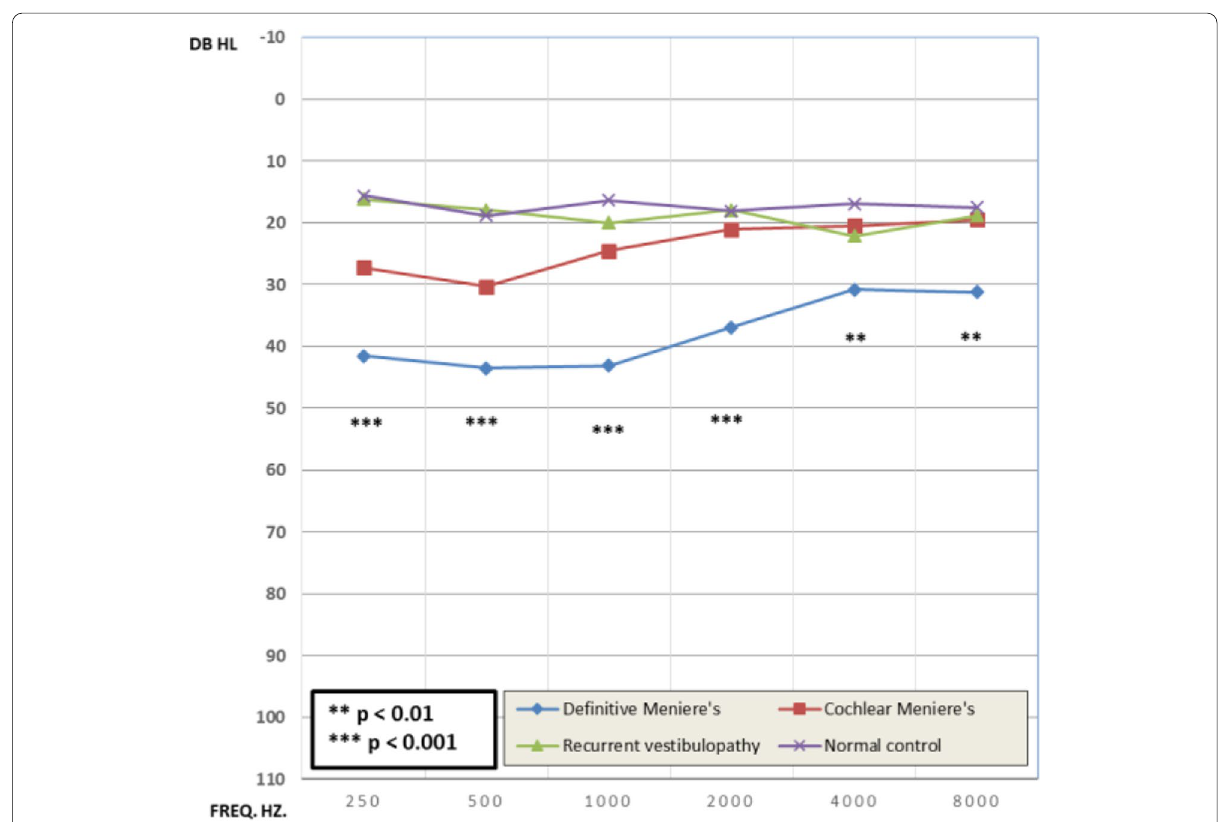
Fig. 3 Left ear audiogram, mean values. The left ear audiogram is significantly ( p < 0.001) affected in the definitive Meniere’s and the cochlear Meniere’s groups than other group especially at 250, 500, 1000, and 2000 Hz frequencies